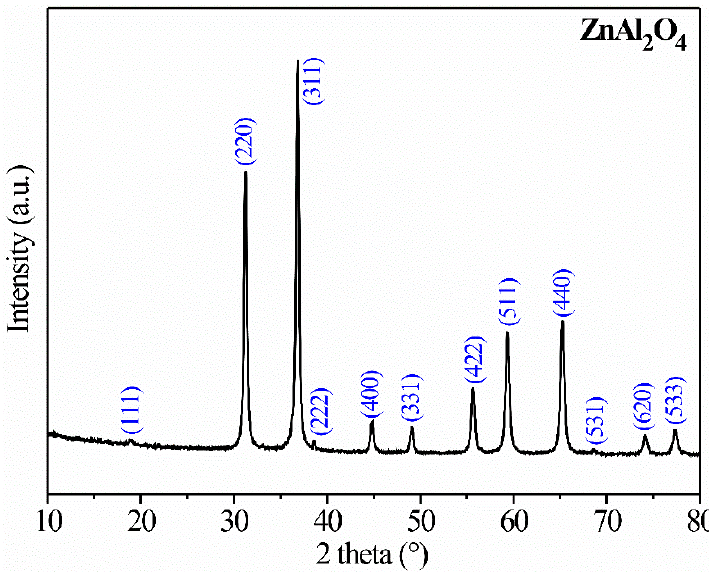
Figure 2 . X-ray diffractograms of ZnAl 2 O 4 powders calcined at 300 °C. Figure 2. X-ray diffractograms of ZnAl 2 O 4 powders calcined at 300 ◦